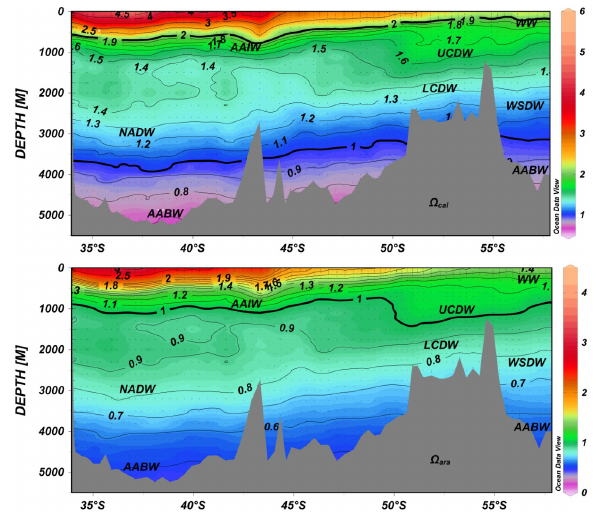
Fig. 4. The vertical distribution of the calcite saturation, (cid:127) cal , and aragonite saturation, (cid:127) ara , from February to March 2008 in the southeast Atlantic sector of the Southern Ocean. The calcite and aragonite saturation horizon is